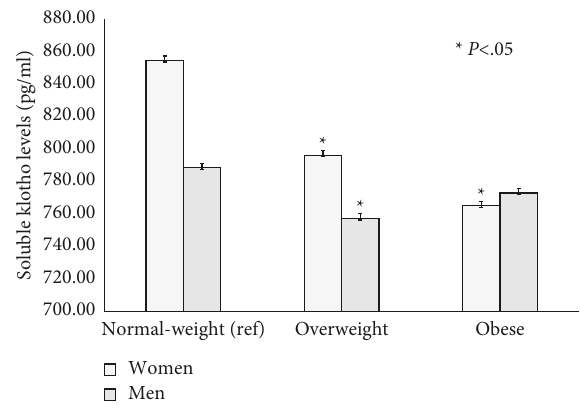
Figure 1: Sex-specific BMI categories and serum soluble klotho levels.